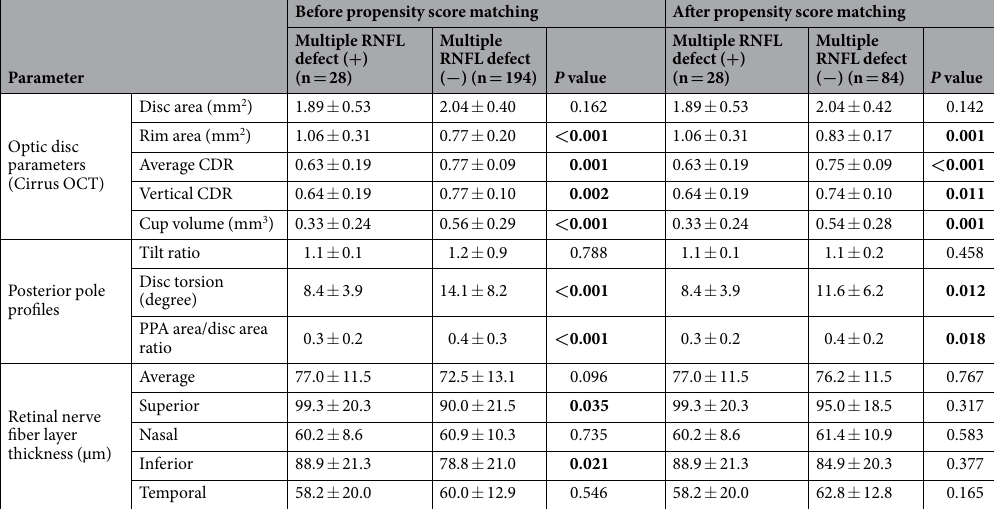
10 (58.8%) had an isolated parafoveal scotoma, and 7 (41.2%) had combined parafoveal scotomas. Other visual field defect patterns were found as follows: Three patients had nasal scotoma. Five patients had visual field defects in the Bjerrum area. Three patients had no visual field defect. On a pattern deviation plot, 12 paracentral visual field points were compared between the two groups. In sub- jects with multiple RNFL defects, the pattern deviation value ( − 2.3 dB) of the lower paracentral visual field points was lower than in those without them ( − 1.1 dB, P = 0.015; Supplementary Fig. S1). Pattern deviation ( − 6.6 dB) of the upper paracentral VF points displayed a lower value in patients without multiple RNFL defects than in patients with multiple RNFL defects ( − 3.2 dB, P = 0.004). Among common vascular diseases, hypertension was associated with multiple RNFL defects by multiple logis- tic regression analysis ( P < 0.001; Table 4). Among uncommon diseases, end-stage renal disease and cerebrovas- cular disease were both related to multiple RNFL defects by multiple logistic regression analysis (both P < 0.001;